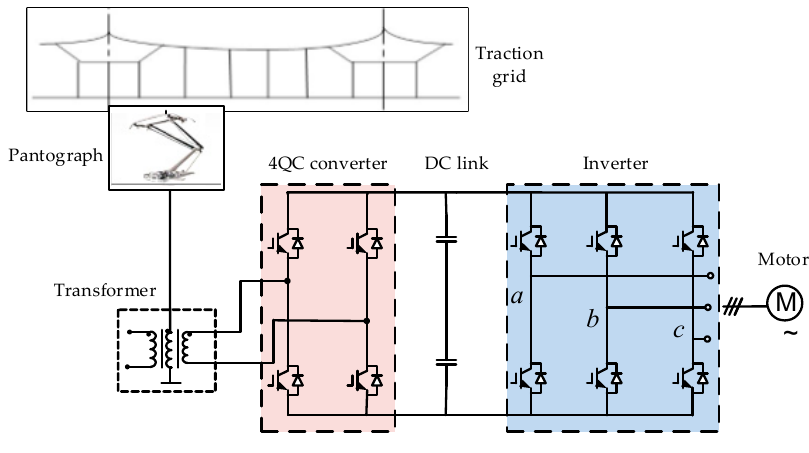
Figure 1. Diagram of traction drive system.